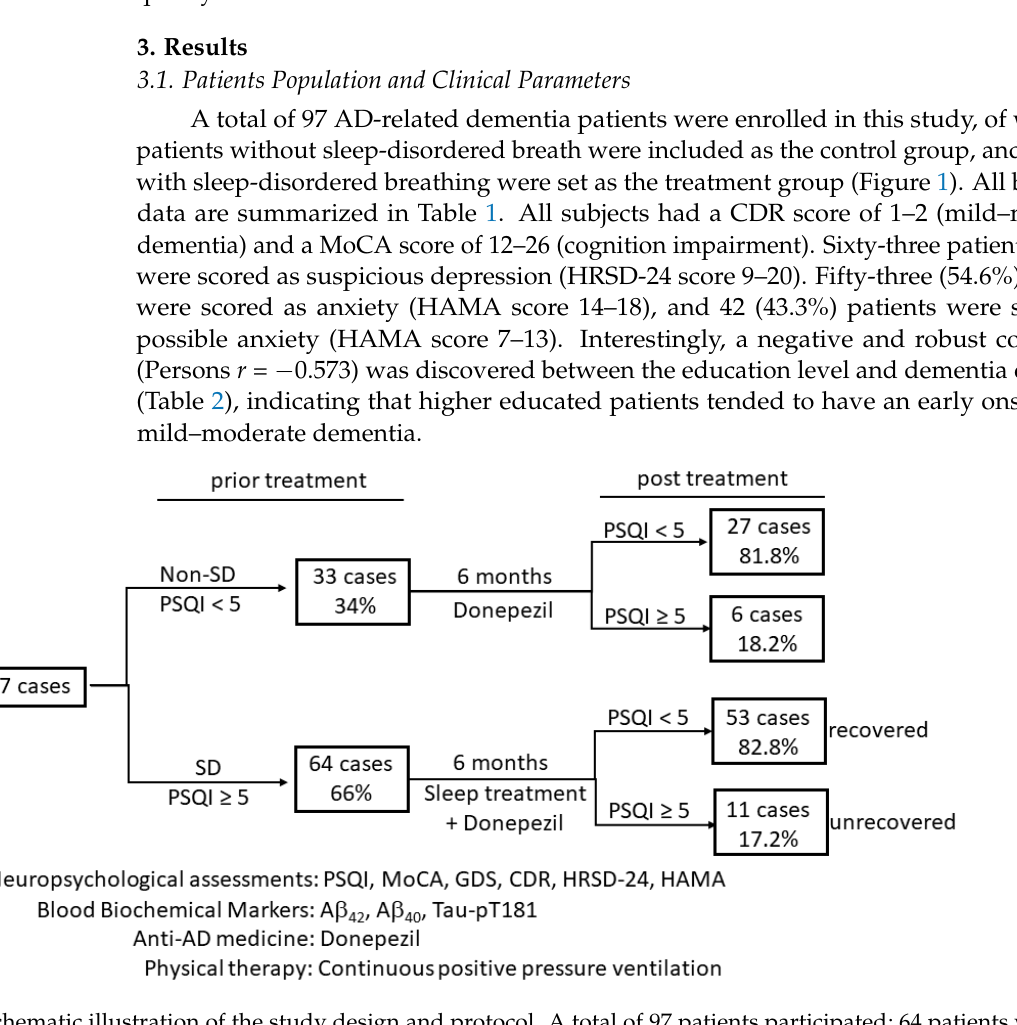
Figure 1. A schematic illustration of the study design and protocol. A total of 97 patients participated; 64 patients were diagnosed with sleep disorders and were subjected to sleep interventions in addition to donepezil treatment. The other 33 cases without sleep disorders received donepezil only. After a 6-month treatment, patients were re-assessed and divided into recovered or unrecovered subgroups groups based on the Pittsburgh Sleep Quality Index (PSQI) scores. SD: sleep-disorder. Table 1. Patient Biometrics